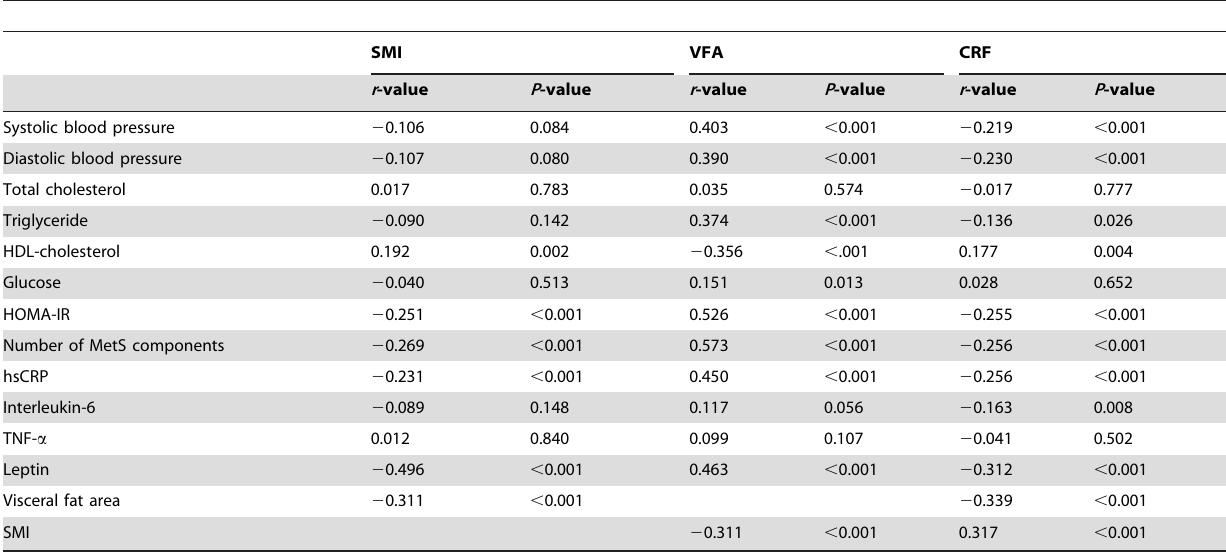
Table 3. Spearman’s partial correlation analysis of skeletal muscle index (SMI), visceral fat area (VFA) and cardiorespiratory fitness (CRF) with cardiometabolic parameters adjusting for age and gender